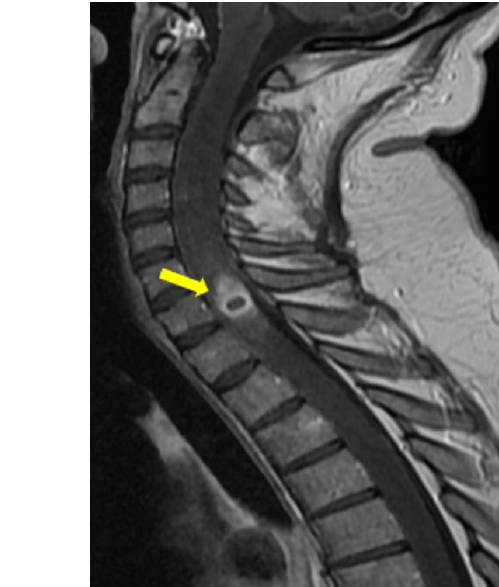
Figure 5. MRI of the cervical spine—sagittal DWI ( a ) and ADC map ( b ): the lesion is hyperintense on DWI, and restricted diffusion is illustrated on ADC map. The yellow arrow indicates the expansive cystic intramedullary process.